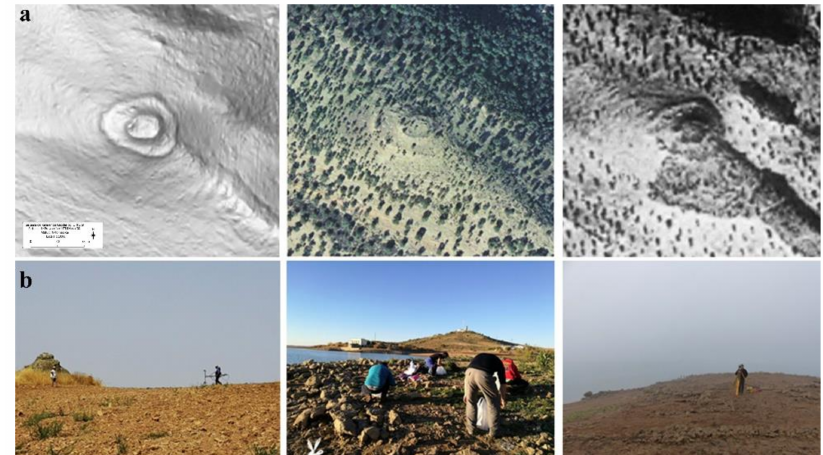
Figure 4. ( a ) Workflow for the identification of archeological sites using LiDAR-PNOA data combined with PNOA multitemporal imagery. ( b ) Geophysical survey, ground prospection, and